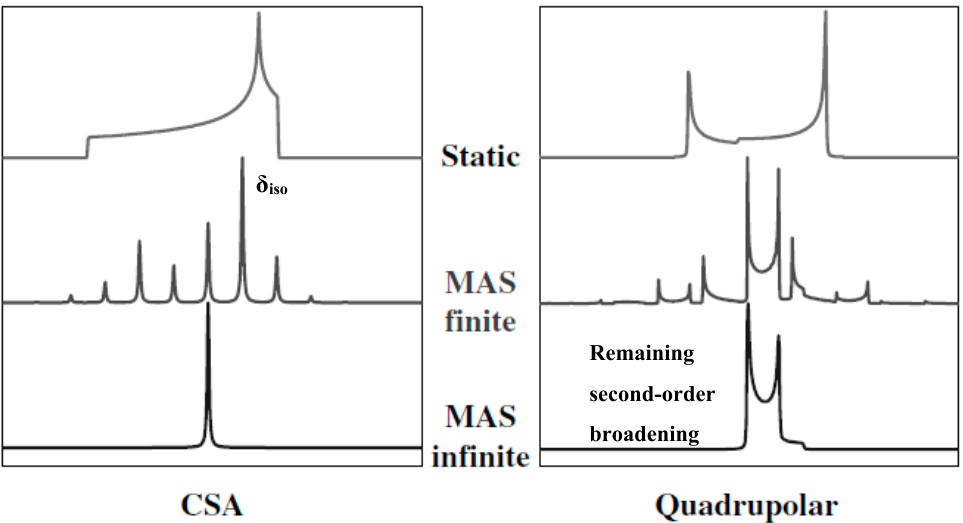
Figure 5. Simulated powder lineshapes in spectroscopy of spin-1/2 nuclei with only CSA (left) and spin-n/2 nuclei with only quadrupolar interaction (right) at static, finite MAS and infinite MAS conditions as denoted in the figure. With infinite MAS, CSA is completely removed in the left bottom figure, however a broad quadrupolar lineshape presents in the bottom right figure due the remaining second-order quadrupolar broadening. Adapted with permission from Ref. [55]. Copyright 2002, Wiley.